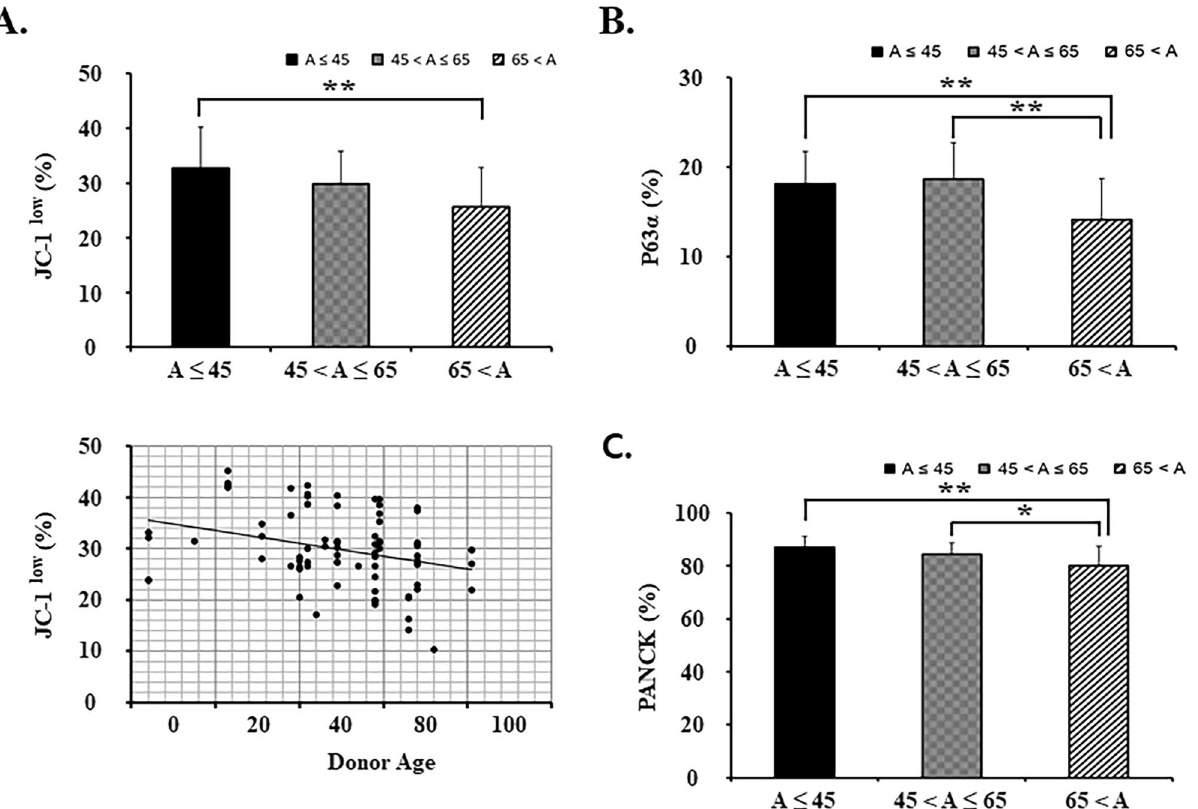
Figure 2. The activation of limbal stem/progenitor cells in limbal explant outgrowth sheets from different donor’s ages. ( A ) Percent of JC-1 low cells from FACS analysis and relationship with donor age are shown. JC1 dye exclusion reflects ABCG2 activity and result in the JC1 low cohort. ( B , C ) p63α and PANCK positive cells from FACS analysis are shown. *p < 0.05 (vs. 65 < A), **p < 0.01 (vs. 65 < A), n = 6 from 3